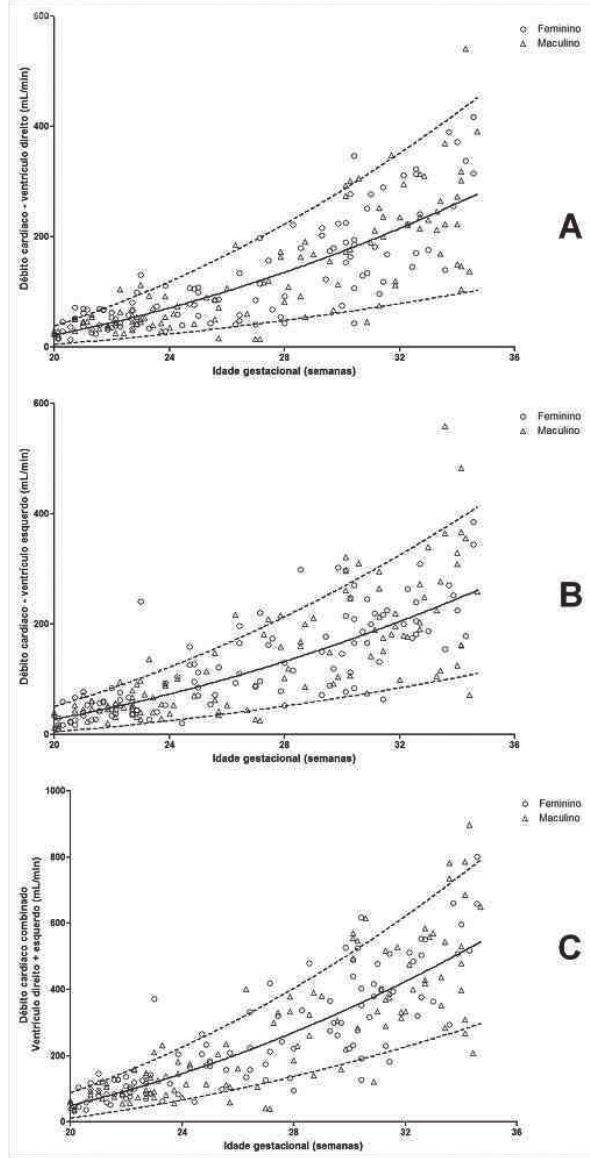
Tabela 4. Percentis 5, 50 e 95 para a fração de ejeção – direito e esquerdo, considerando ambos os fetos masculino e